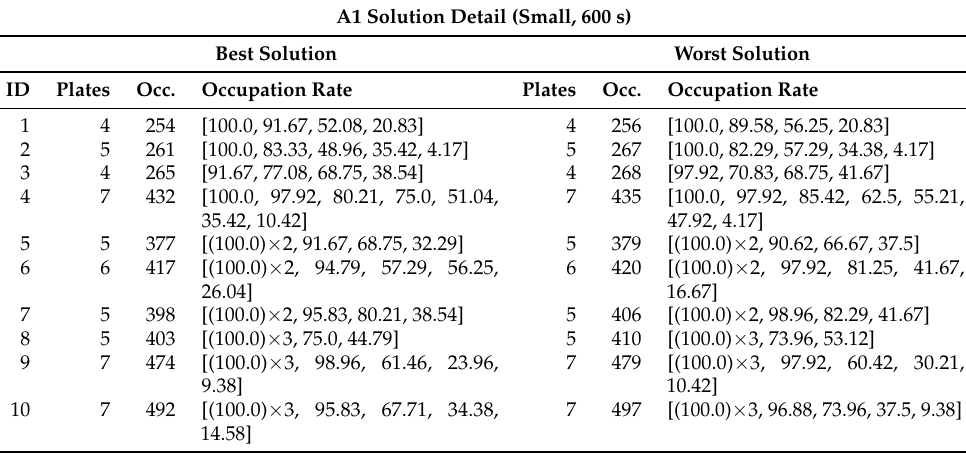
Table A8. A1 best and worst solutions obtained for small files, limited to 600s.